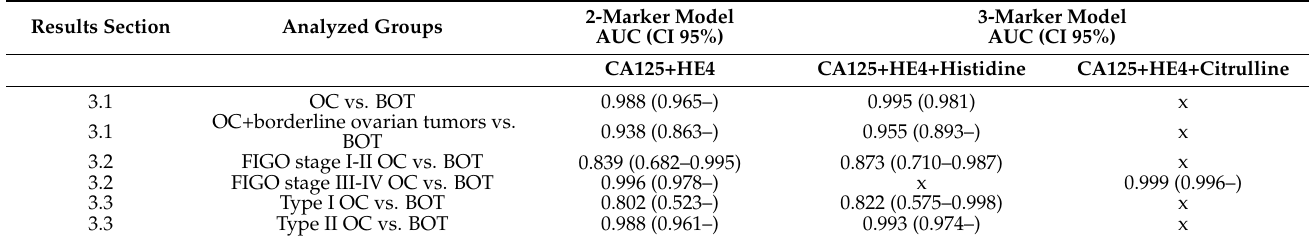
Table 4. Areas under the receiver operating characteristic (AUC of ROC) curves for multivariate models comparing their diagnostic utility in differential diagnosis between the analyzed